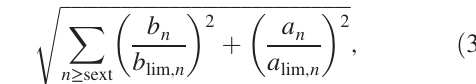
FIG. 10. Multipole FOM of magnets before and after